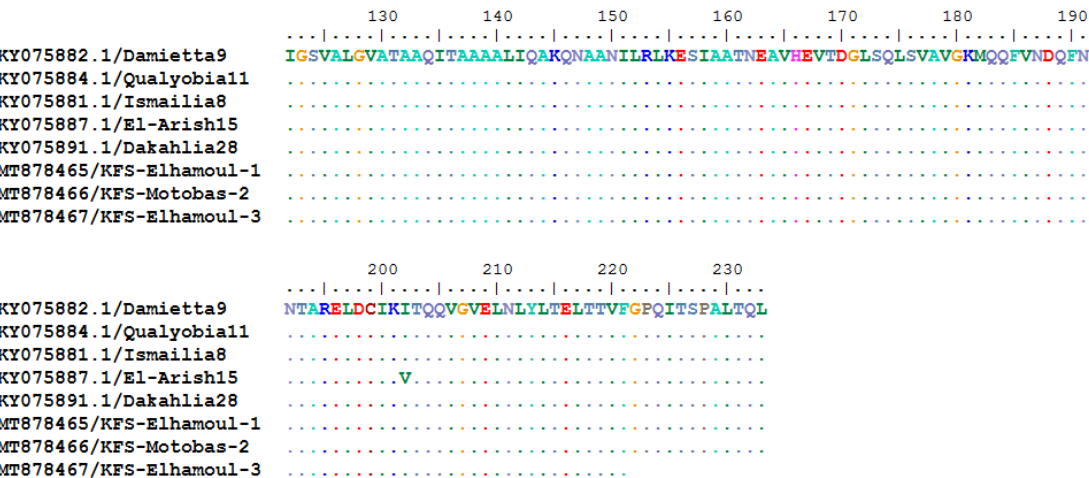
Figure 4. BioEdit Clustal W algorithm alignment of the Egyptian GVII.1.1 strain’s deduced amino acid sequences showing no amino acid substitution in our strains (KFS-Motobas-2, KFS-Elhamoul-1, and KFS-Elhamoul-3).